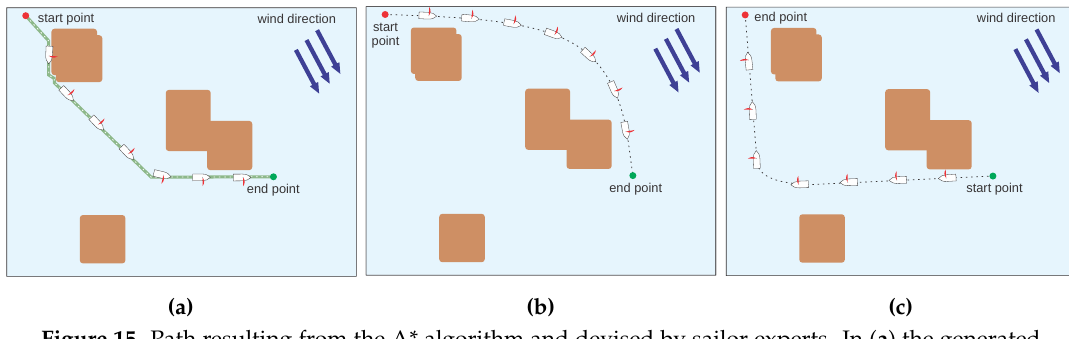
Figure 15. Path resulting from the A* algorithm and devised by sailor experts. In ( a ) the generated path by the A* algorithm, which is very similar to the Q-Learning resulting path shown in Figure 16a. Pictures ( b , c ) show the generated possible paths made by the sailor experts considering the wind in the same direction and versing the boat so that the start and end points change.